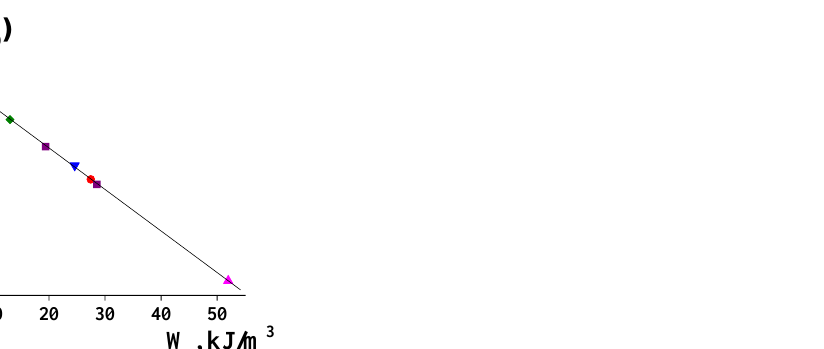
jet (c) due to high shear and normal stresses.